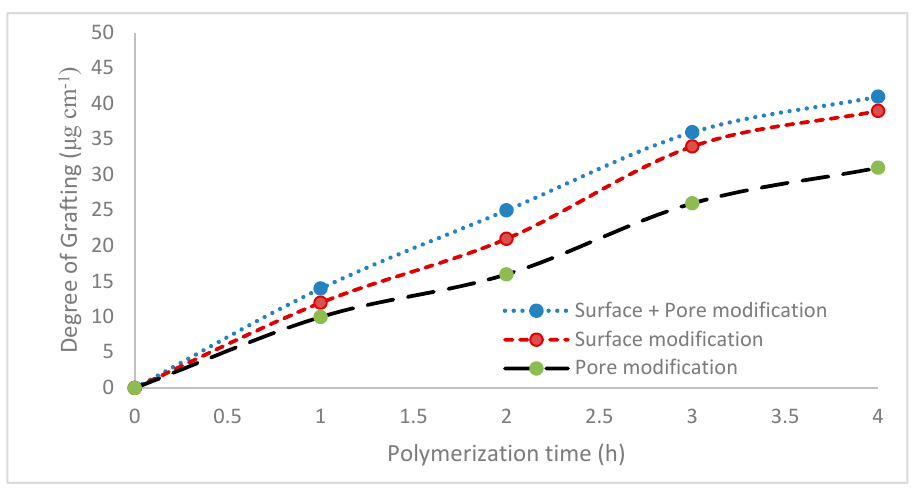
Figure 1. Variation of degree of grafting with polymerization time for the three initiator immobilization strategies. The dotted, small dashed and loner dashed lines represent pore modification, external surface modification and external surface and pore modification, respectively.